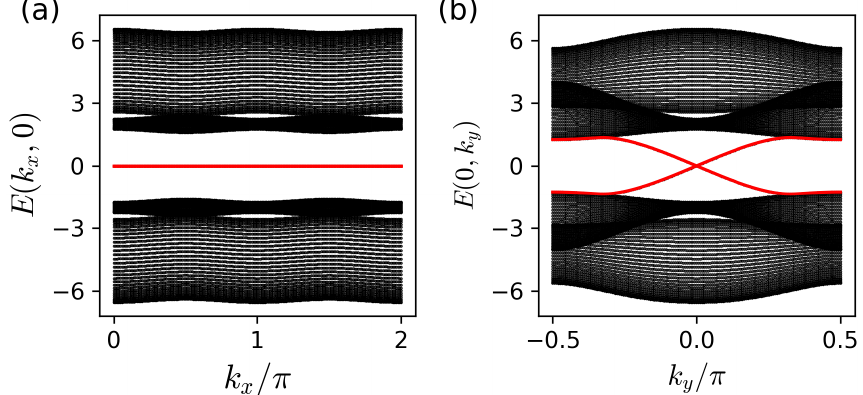
Figure 2: The spectrum of a finite slab in the z -direction in the LCI phase, when q = 2. = 0.4 t The parameters are M = 1.2 t , t . (a) The surface states (highlighted in y x y red) are dispersionless in k and span the BZ. (b) The surface states (highlighted in x red) disperse in k , with linear dispersion near zero energy, with two gapless modes y of opposite slopes belonging to opposite open surfaces of the slab. The surface state living on the xz crystal surface, has a linear dispersion in k near zero energy (not z shown